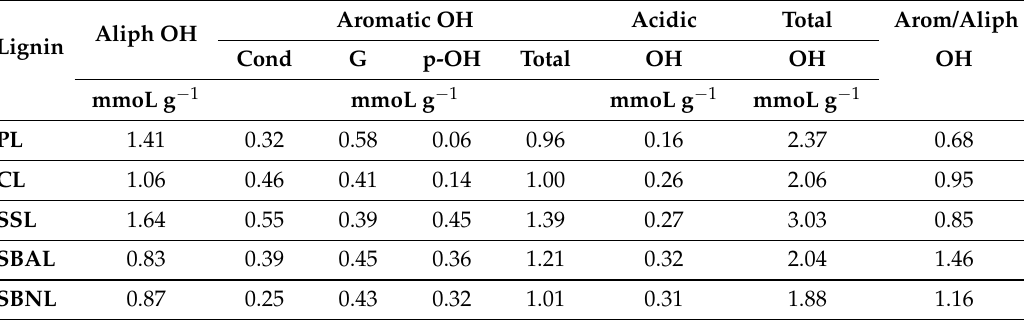
Table 3. 31 P NMR analysis of lignin samples. The abbreviations of lignin fractionated from pine sawdust (PL), cotton stalks (CL), sweet sorghum bagasse (SSL), spruce bark with (SBAL) and without acid addition (SBNL) were